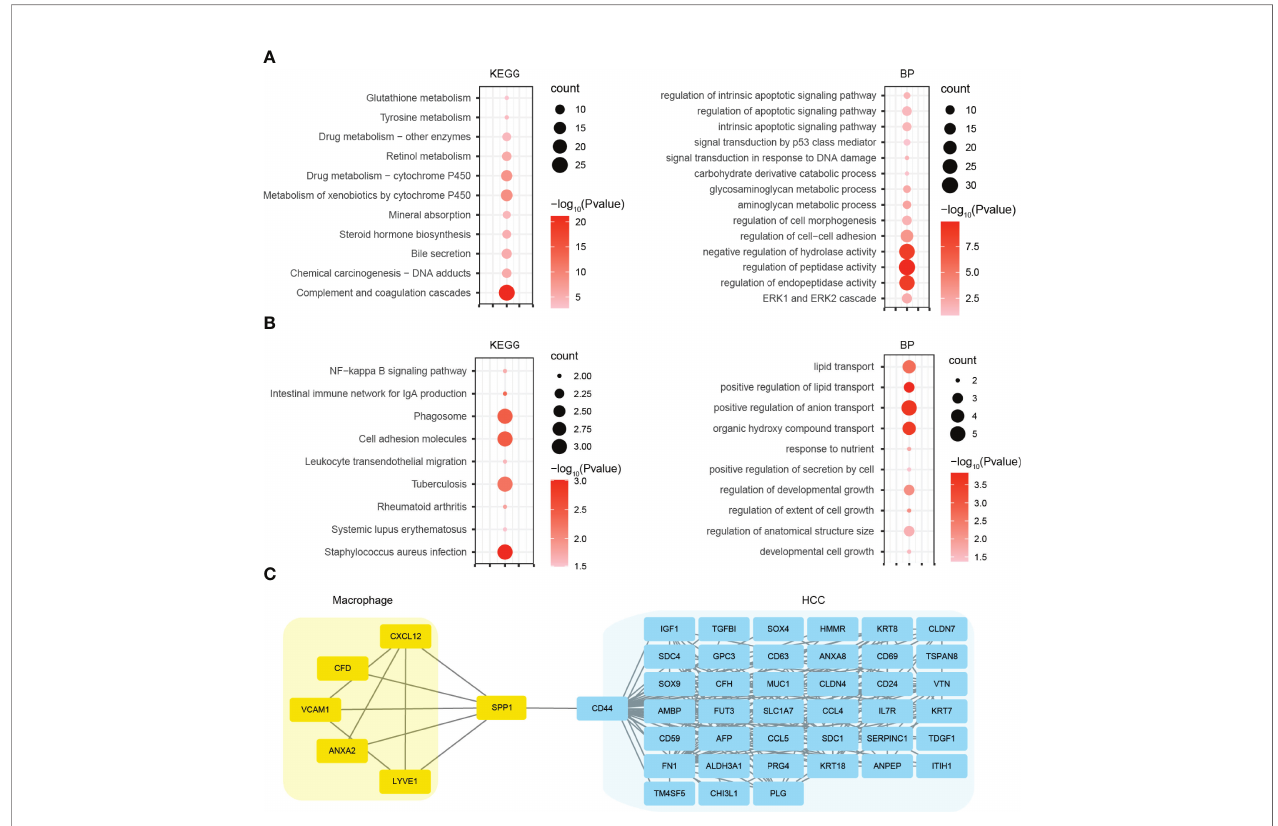
FIGURE 4 | GO and KEGG pathway analyses and PPI network construction. (A) KEGG and GO BP analyses using the DEGs of HCC malignant cells. (B) KEGG and GO BP analyses using the DEGs of macrophages. (C) PPI network using the genes directly interacting with SPP1 or CD44. GO, Gene Ontology; KEGG, Kyoto Encyclopedia of Genes and Genomes; PPI, protein – protein interaction; BP, biological process; DEGs, differentially expressed genes; HCC, hepatocellular